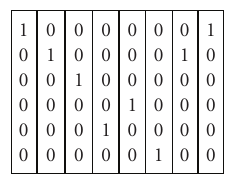
Figure 5: Time-series matrix X